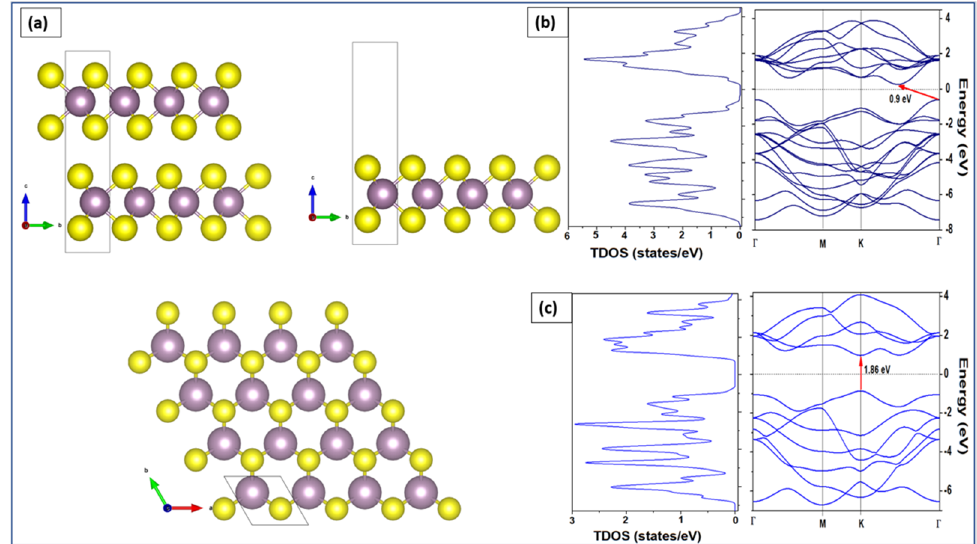
Figure 6. ( a ) Bulk MoS 2 ( top-left ), monolayer MoS 2 ( top-right ), and top view of MoS 2 monolayer ( bottom ). Total density of states ( left ) and band structure ( right ) of the ( b ) bulk and ( c ) monolayer.